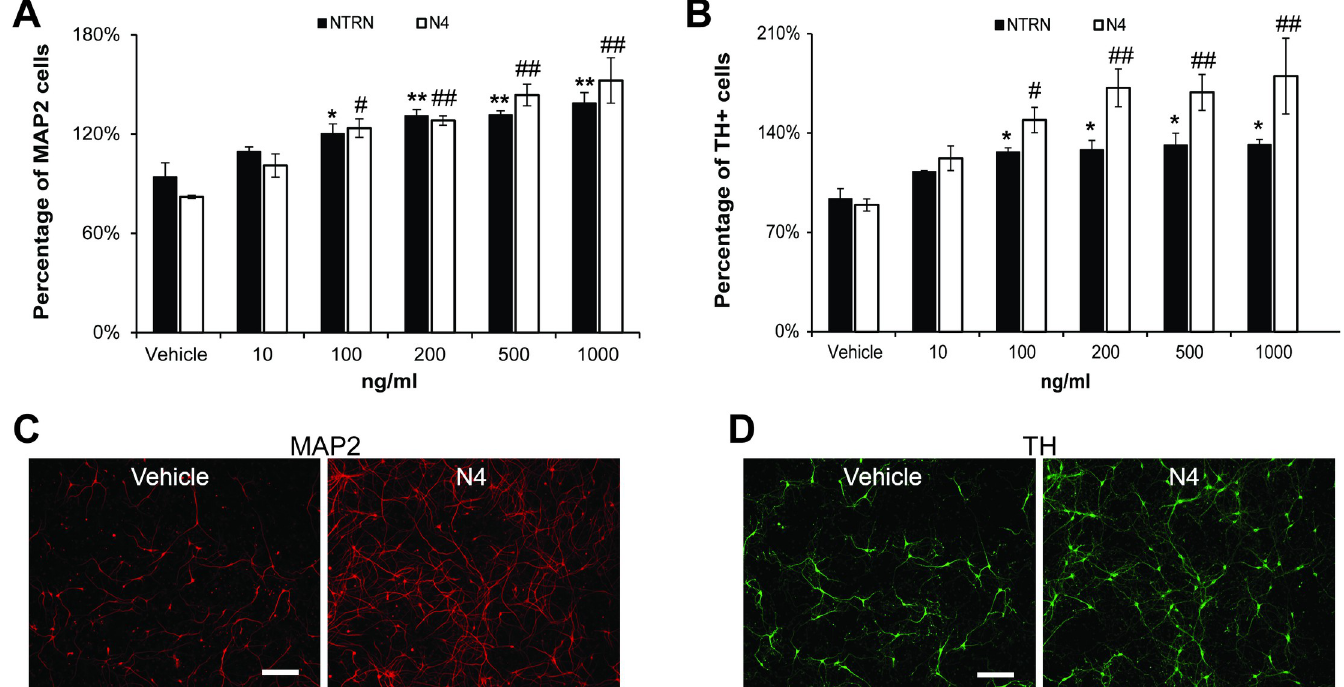
Fig 2. Effect of NRTN and variant N4 on basal survival of all neurons from the SN as indicated by MAP2 (A) or DA neurons as indicated by TH (B). Both NTRN (closed bars) and N4 (open bars) increased the survival of total neurons and TH + neurons isolated from the SN after six days in culture. The NTFs were added the day of culture preparation within an hour of culture preparation.( � equals p < 0.05 or �� = p < 0.005, # < 0.05 or ## < 0.005 ANOVA followed by Dunnett post hoc test on data normalized to untreated control within in each treatment; n = 3 to 4 experiments per condition.) Representative images of cells isolated from the SN cultured for 6 days with or without 1000 ng/ml of N4 immunostained for MAP2 (C, red) and TH (D, green). Scale bars indicate 200 microns.